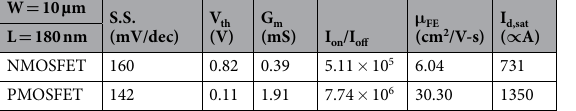
Table 3. Transfer characteristics of multi-channel NMOSFETs and